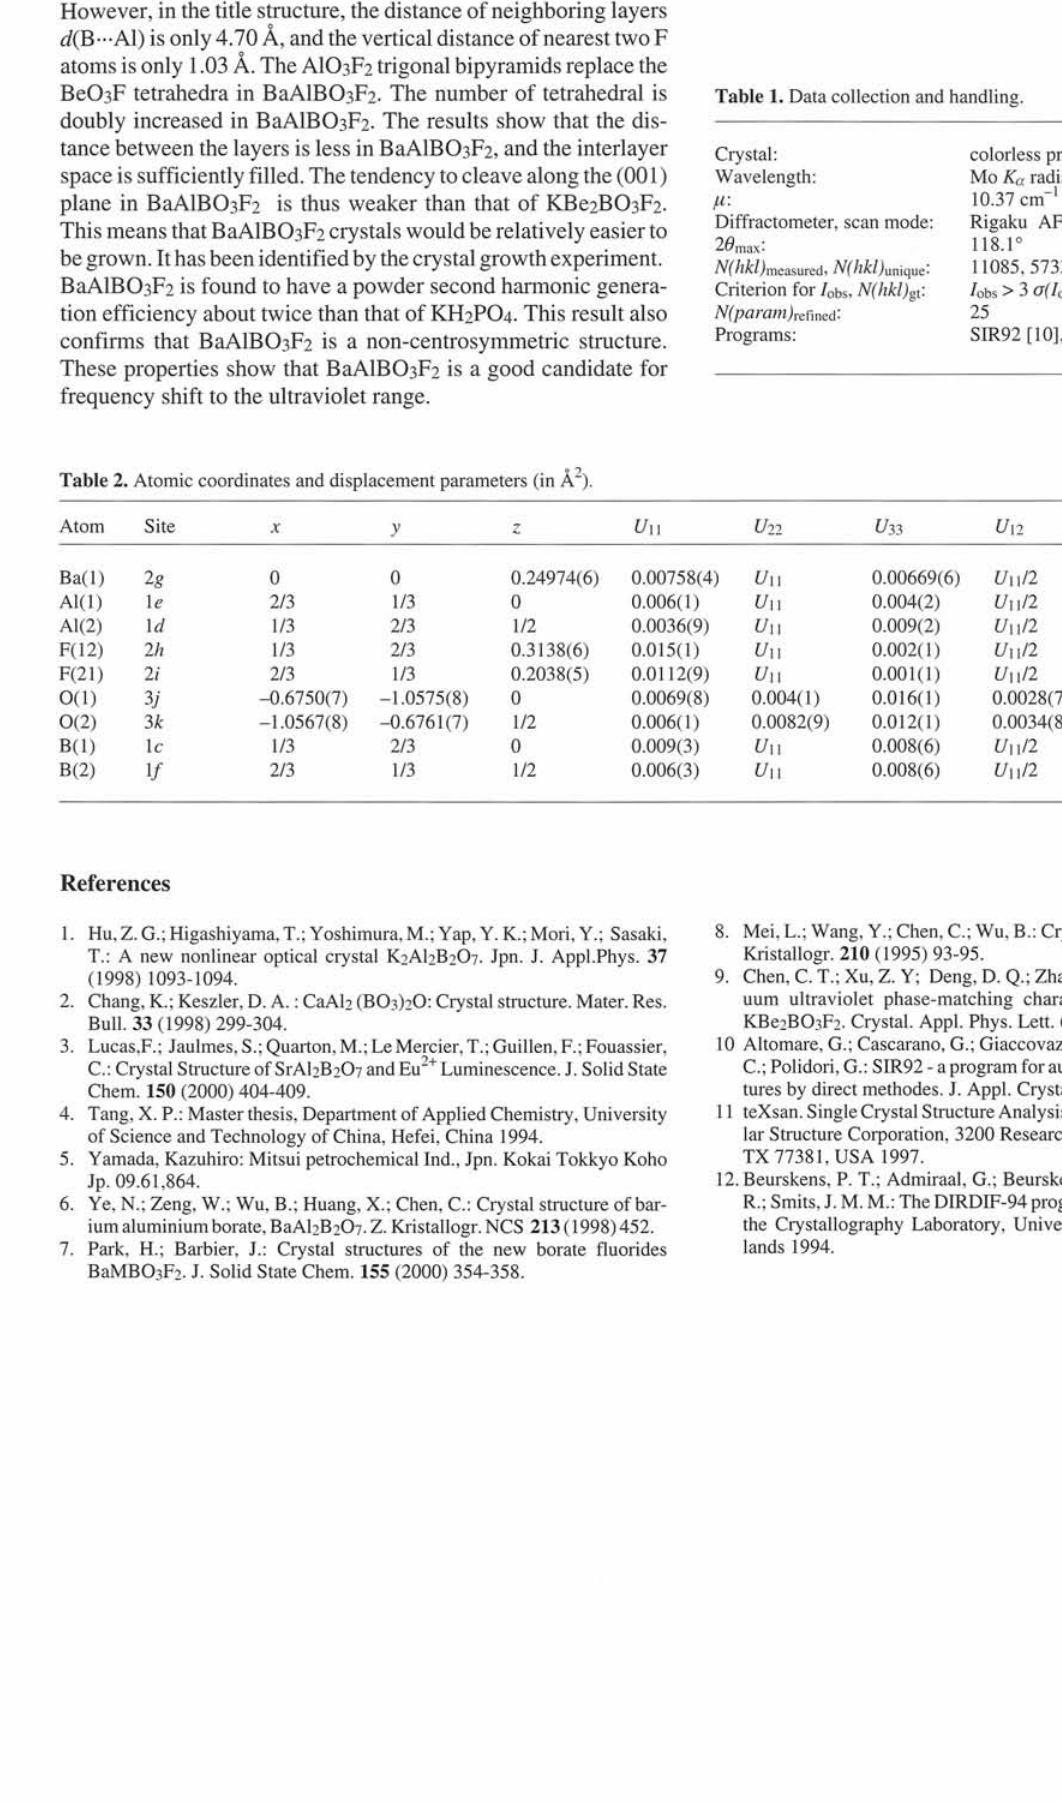
Table 1. Data collection and